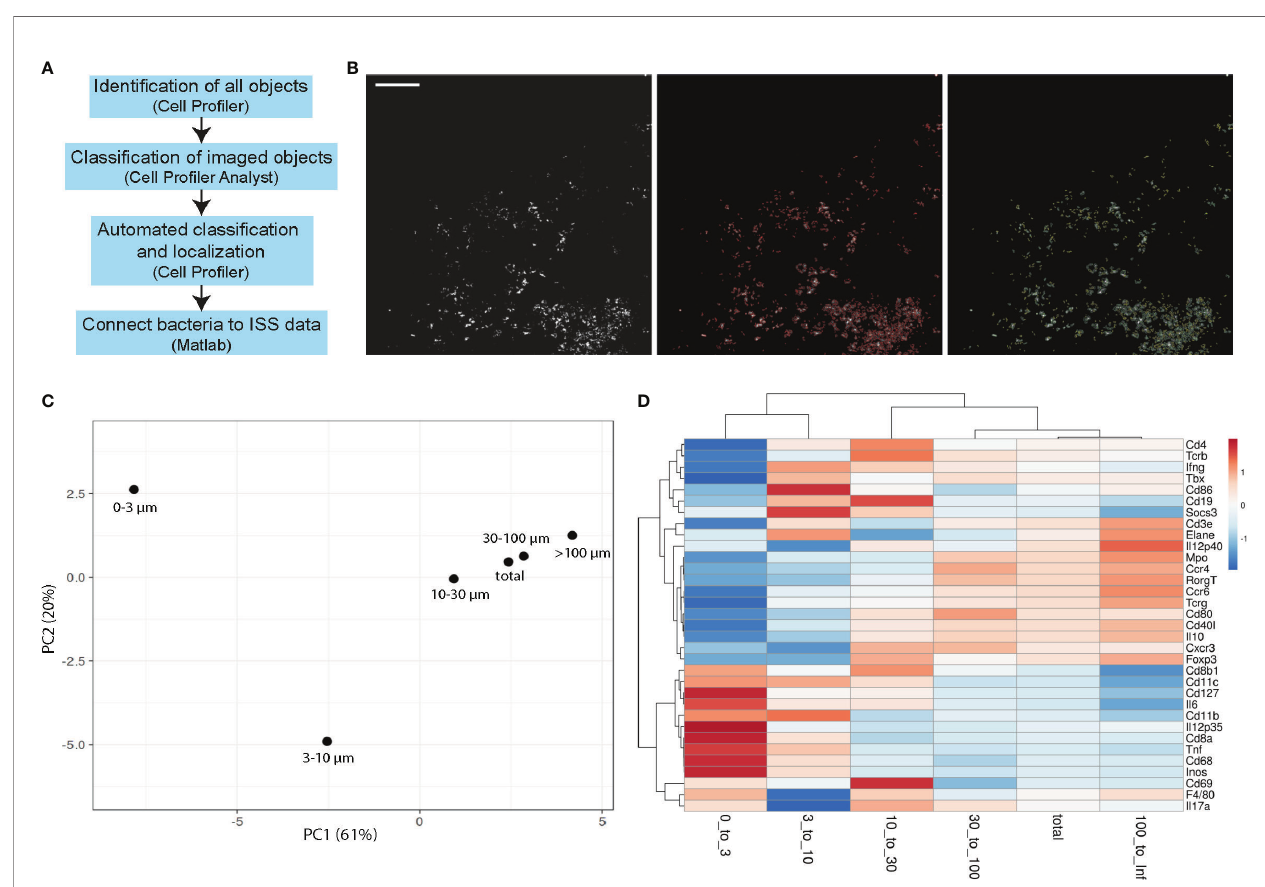
FIGURE 2 | Single bacteria identi fi cation and their immune environment per distance. (A) Work fl ow scheme of single bacteria identi fi cation pipeline development and connection to ISS data. (B) Example of tiled AR image that is used as input into the single bacteria identi fi cation ( fi nal FinalSingleBacteria) pipeline is shown in the left panel. Automated detection of all imaged objects is annotated in red in the middle panel and identi fi ed single bacteria (yellow) and bacteria clumps (green) are in the right panel. Scale bar: 100 m m. (C, D) Principal component analysis (C) and heatmaps (D) of immune transcript frequencies at different distances from identi fi